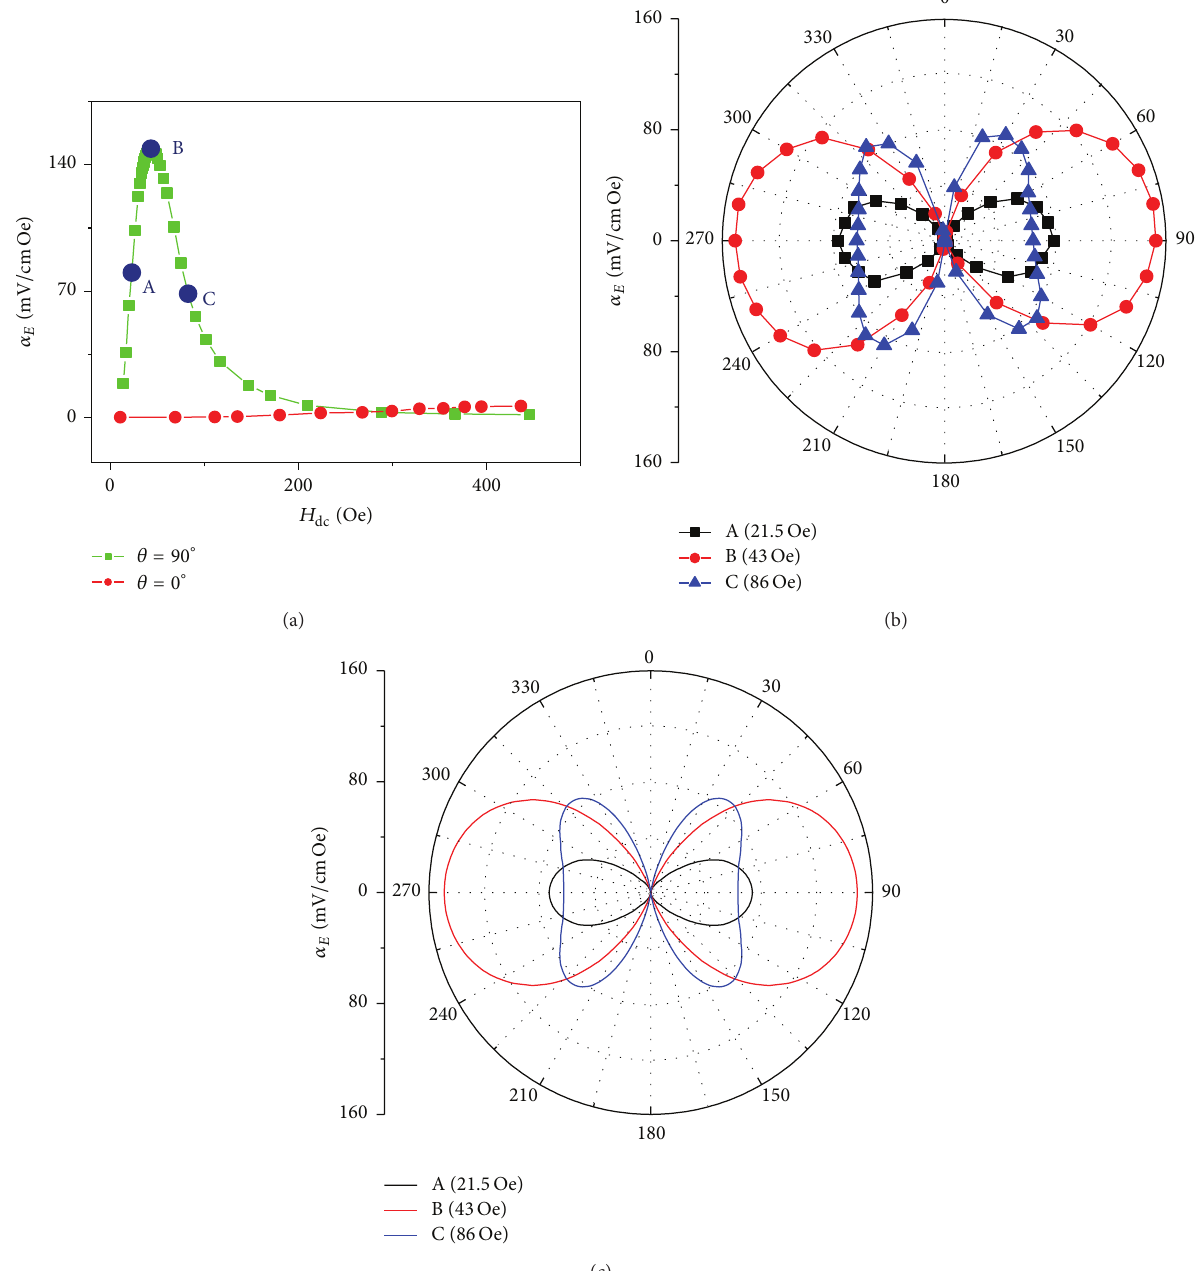
Figure 3: (a) Magnetic-field dependence of ME coefficient 𝛼 𝐸 in the FeBSiC/PZT/FeBSiC trilayer with a dimension of 10 × 5 × 0.5 mm 3